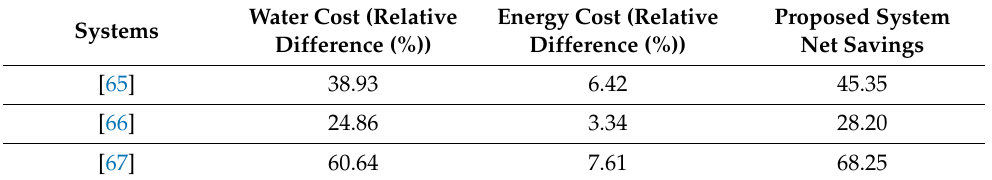
Table 9. Relative water and energy cost savings of the proposed system compared to existing Table 8. Proposed system evaluation in aspects of energy and water consumption.